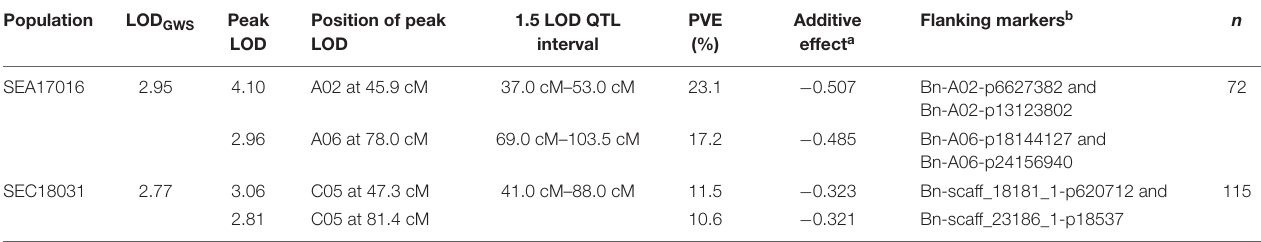
TABLE 1 | Details of quantitative trait loci (QTL) for turnip yellows virus (TuYV) resistance in Brassica rapa BC 2 population SEA17016 and Brassica oleracea BC 1 population SEC18031. Population LOD GWS Peak Position of peak LOD LOD